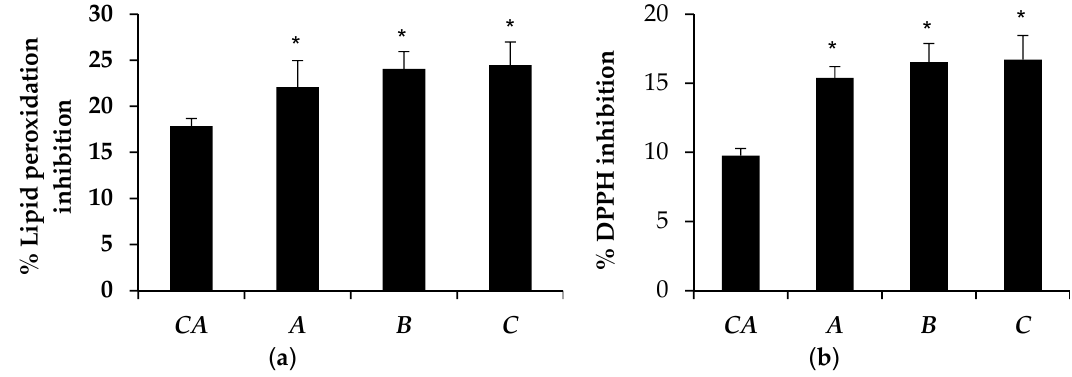
Figure 9. ( a ) Lipid peroxidation inhibition; ( b ) DPPH inhibition of microemulsion A , B , and C compared to 10% CA (Asterisks (*) denote significant statistically differences from 10% CA ; p < 0.05).